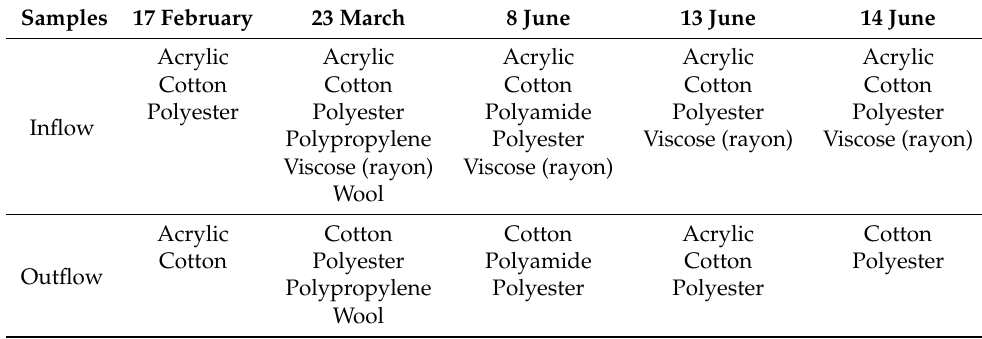
Table 2. Types of MFs and MPs identified in the considered